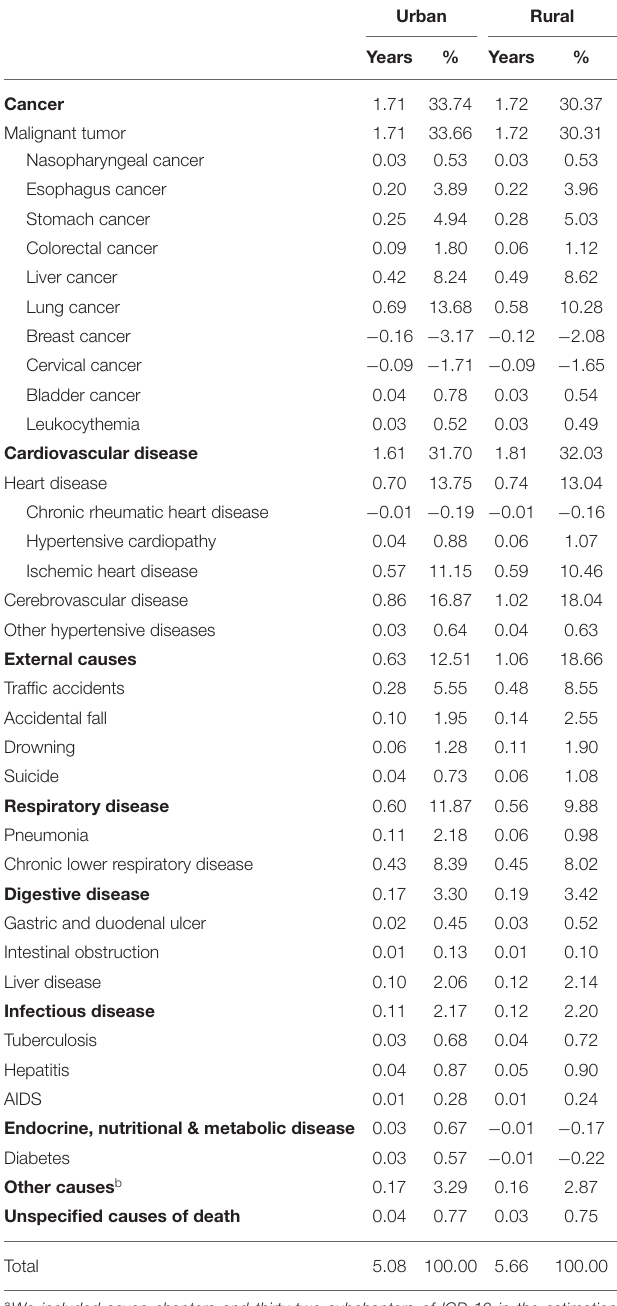
TABLE 3 | Cause-specific contributions to the gender gap in life expectancy at birth a during 2013–2018 by urban-rural